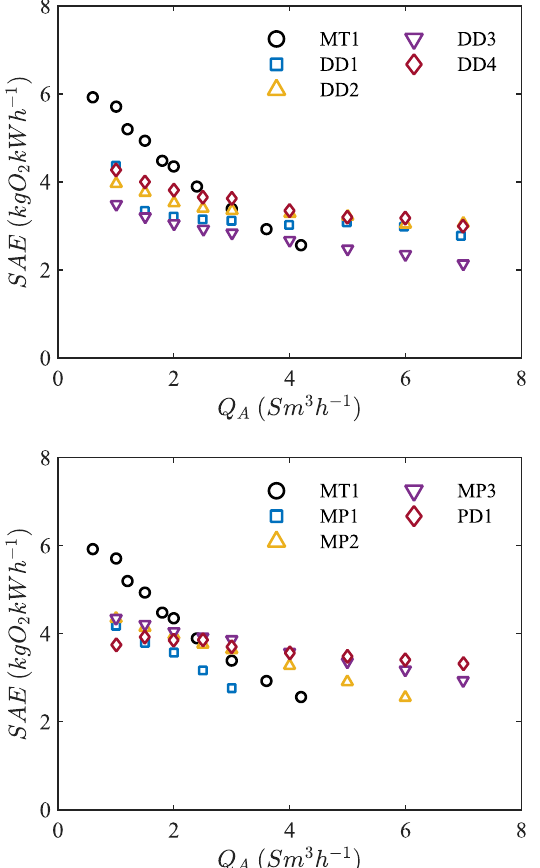
Figure 8. SAE versus Q A for the tested disc, tube and plate diffusers as well as the micro-perforated plate (MP) and tube diffuser (MT1).